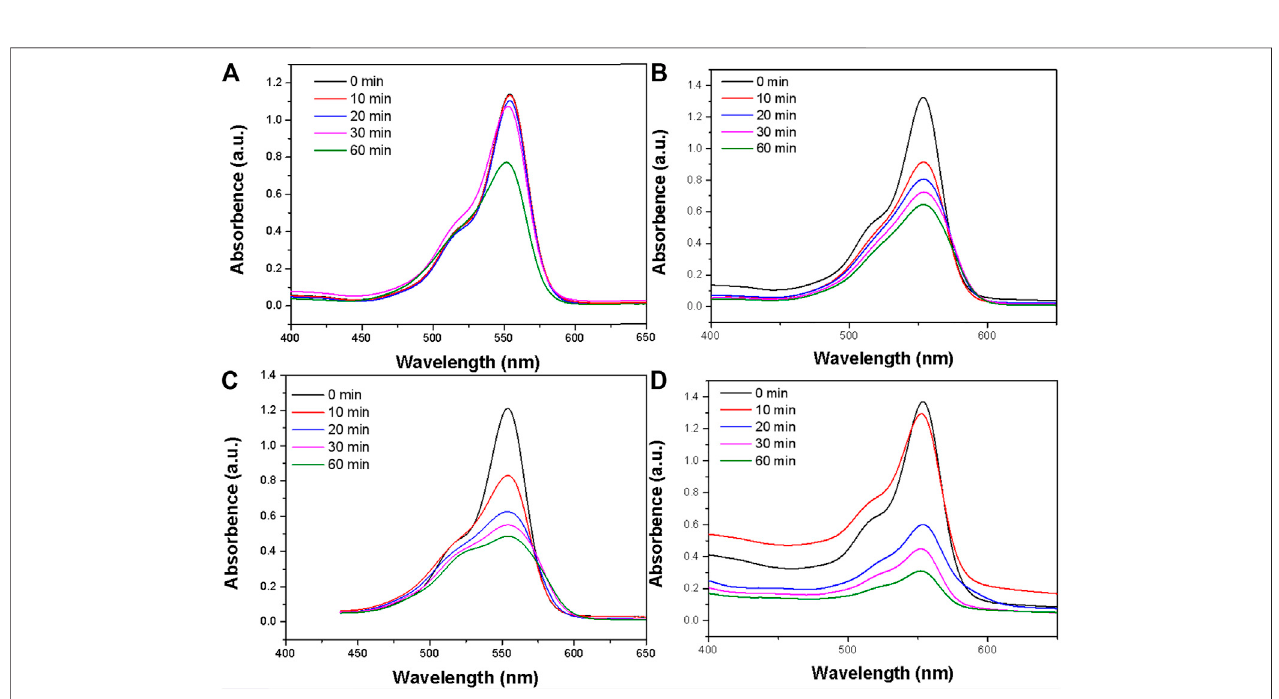
FIGURE 5 | (A) The photodegradation pro fi le of RB in the presence of the Bi 2 S 3 nanocatalyst under pure heat experiment conditions. (B) The photodegradation pro fi le of RB in the presence of the Bi 2 S 3 nanocatalyst under commercial Bi 2 S 3 nanocatalyst. (C) The photodegradation pro fi le of RB in the presence of the Bi 2 S 3 nanocatalyst under UV + NIR experiment conditions. (D) The photodegradation pro fi le of RB in the presence of the Bi 2 S 3 nanocatalyst under visible + NIR experiment conditions, the concentration of Bi 2 S 3 nanocatalyst is 50 ppm in all instances.